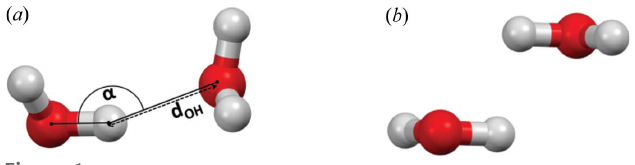
Figure 1 ( a ) Angle (cid:2) and the distance d OH between two water molecules; ( b ) example of an antiparallel water–water